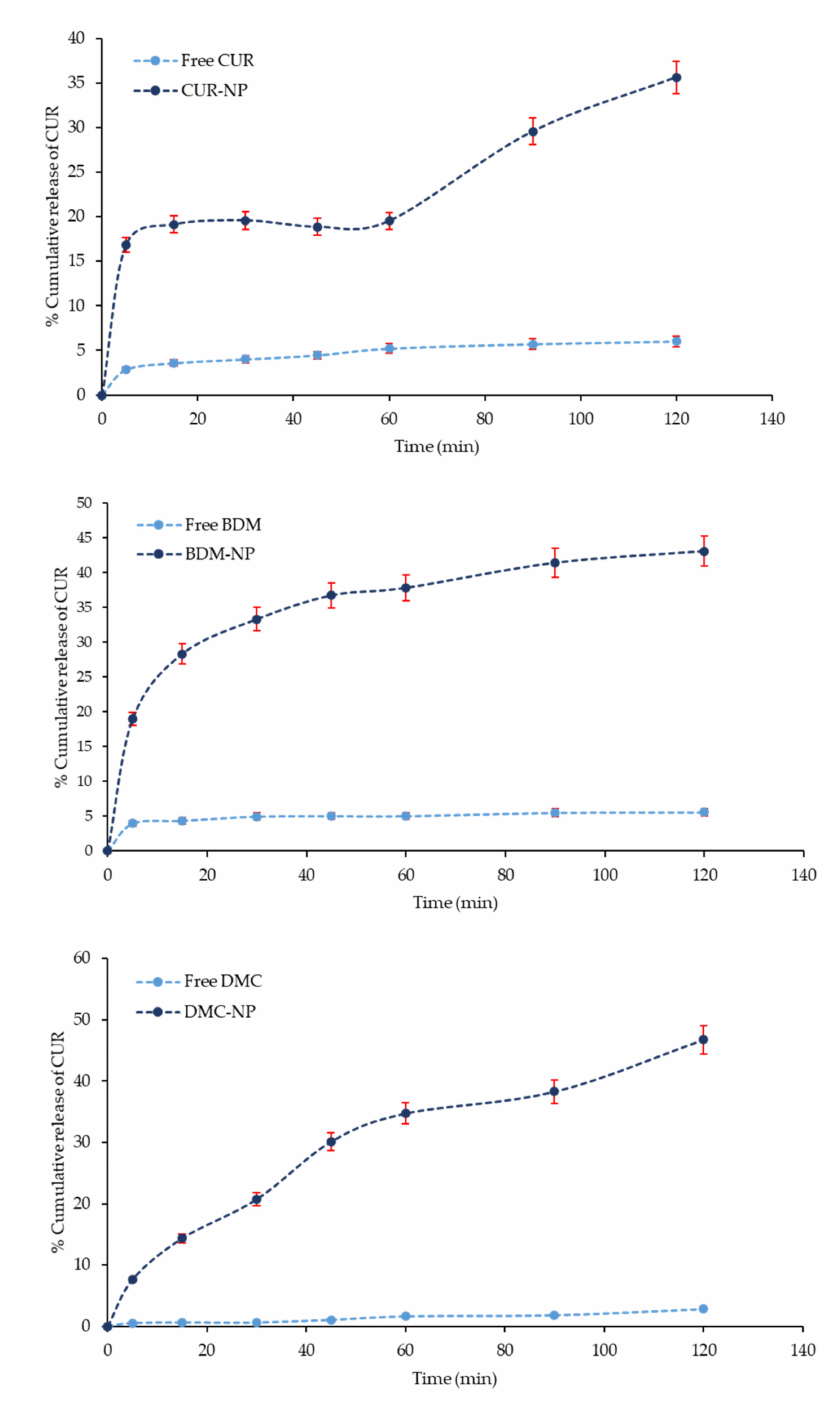
Figure 7. Release profile of CUR, DMC, and BDM from their respective hybrid NP formulation compared with the free compounds evaluated in water (M2). Error bars (red) represent the standard deviation of CUR, DMC, and BDM concentration in